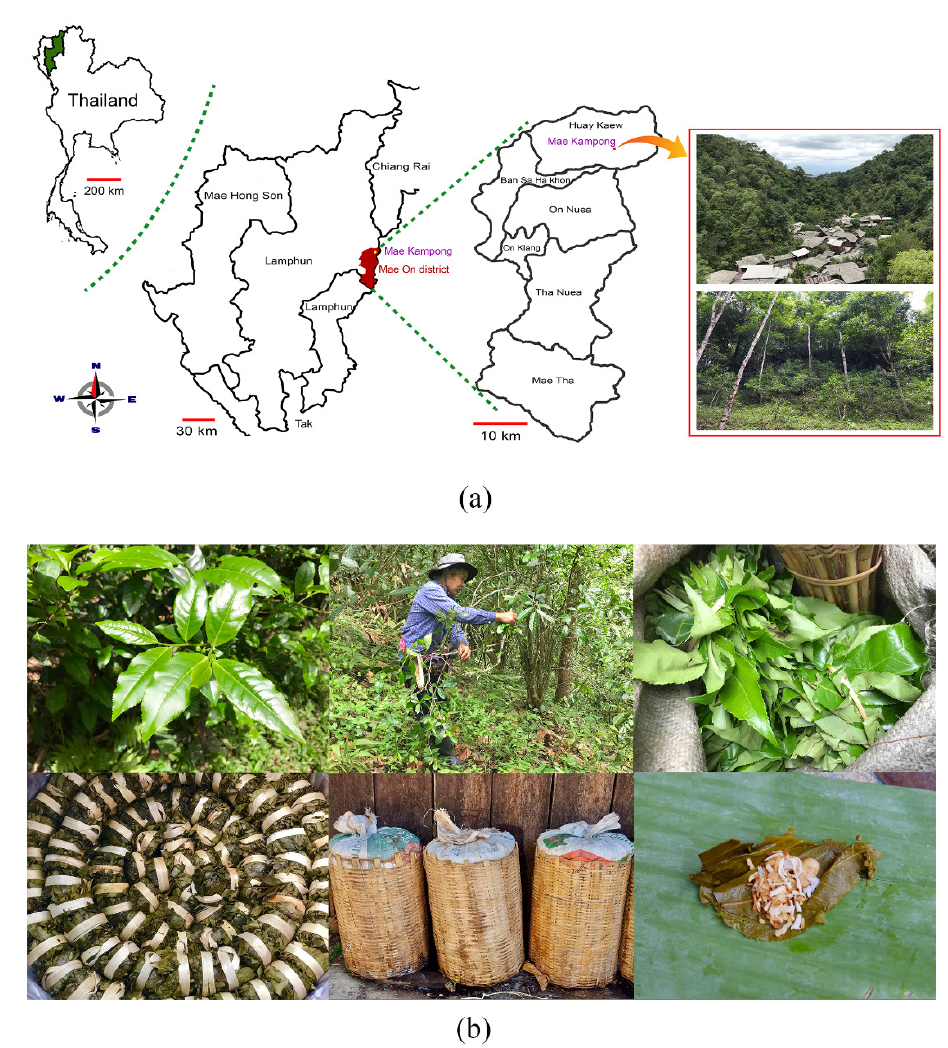
Figure 4. ( a ) Map of Mae Kampong Village, Huay Keaw Sub-District, Mae On District, Chiang Mai province, Thailand; ( b ) Cha Miang leaves (upper) and traditional fermented Assam tea leaves, or “Miang” (lower).